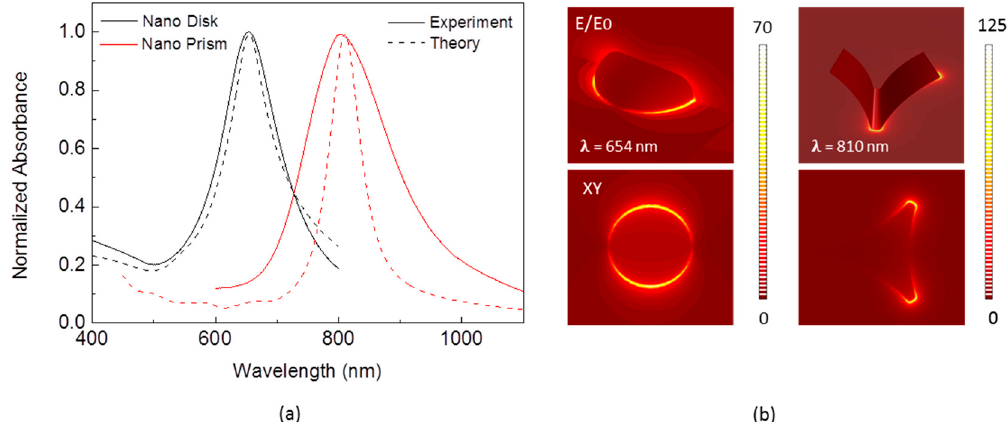
Figure 3. ( a ) Normalized absorbance spectra of disordered arrays of Au nano-disks fabricated by Nanosphere Lithography (NSL). The continuous lines are the experimental data, while the dashed lines are the calculated curves; ( b ) Electric Field Amplification (E/E0) distribution calculated for the fabricated NPs in resonance condition.